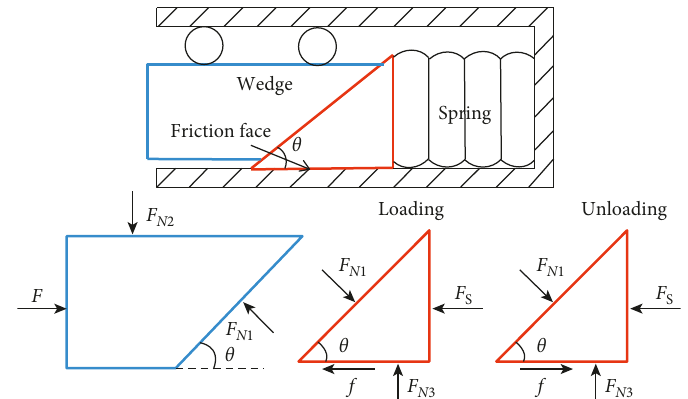
Figure 4: Simplified model of frictional draft gear and analysis of forces applied.